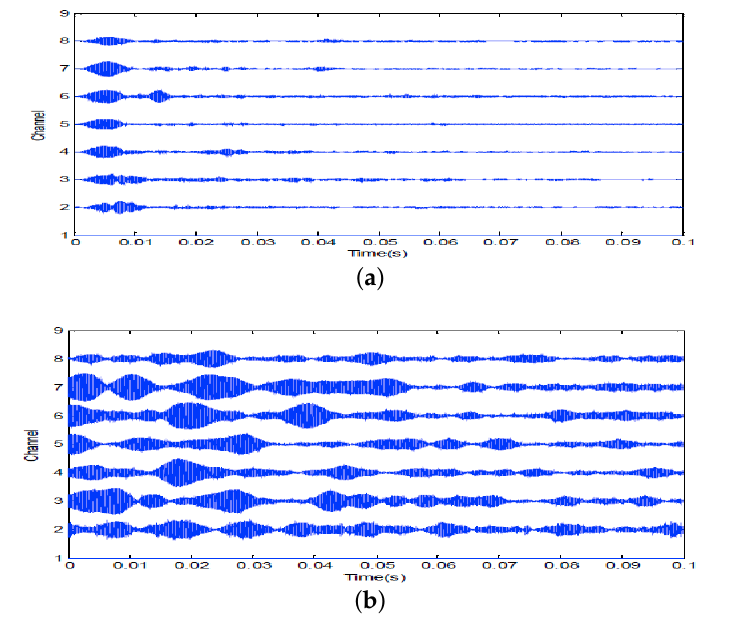
Figure 18. LFM signal at 8–9.5 kHz: ( a ) echoes received by SRA2 after transmitting a probing signal; ( b ) the time-reversed signal for second